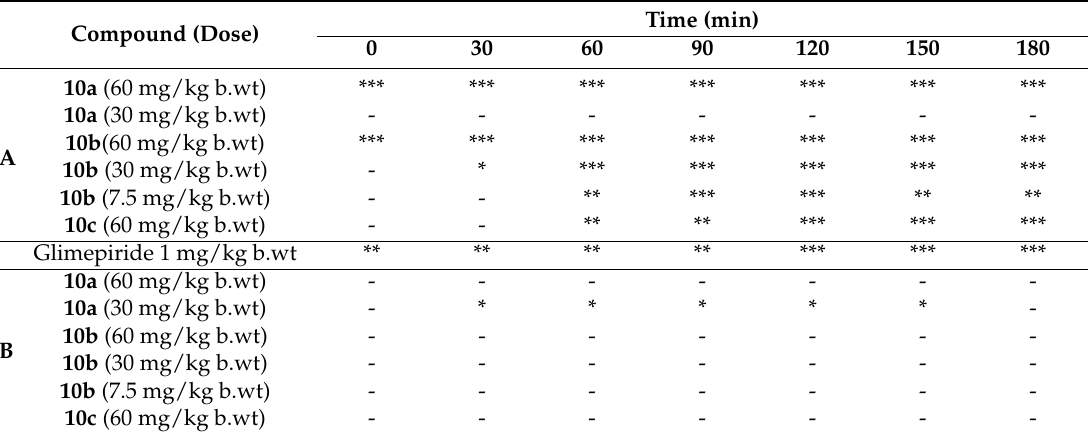
Table 2. P -value for SPSS results in diabetic